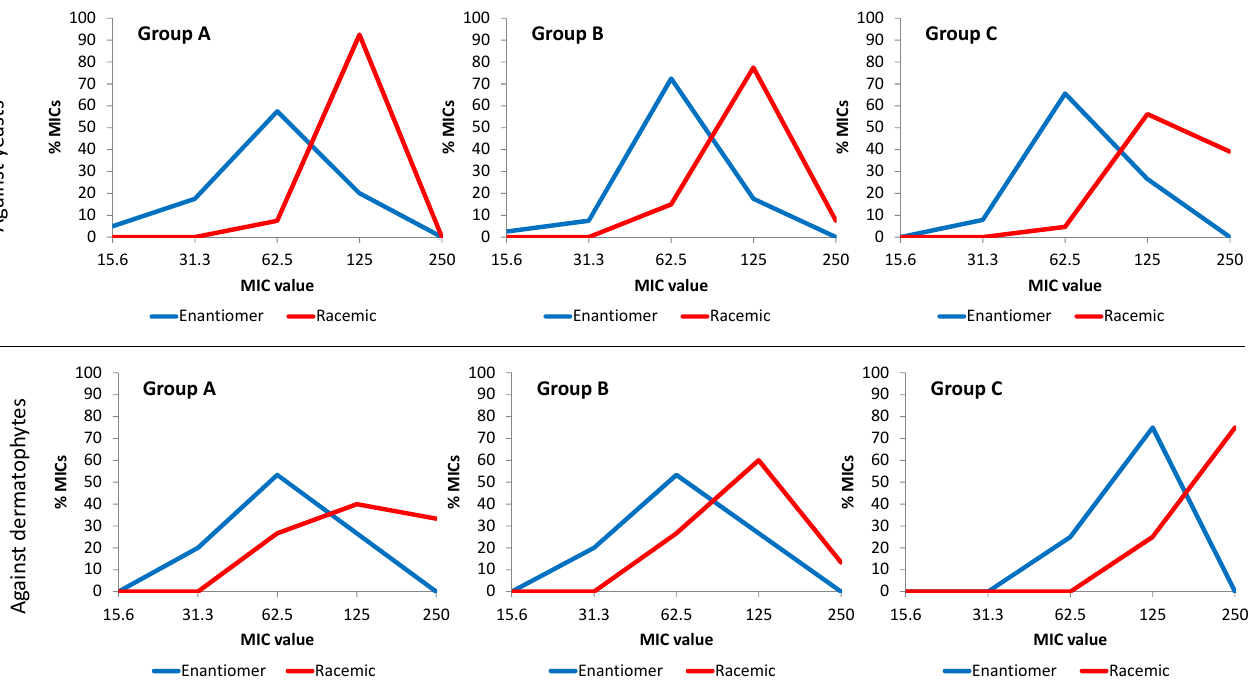
Figure 2. Percentages of the different MIC values (number of MICs at each concentration/total number of MICs) × 100, for the enantiomeric (3 R ) or (3 R ,4 R ) and racemic forms of succinimides of either group (A), (B), or (C) acting against yeasts and